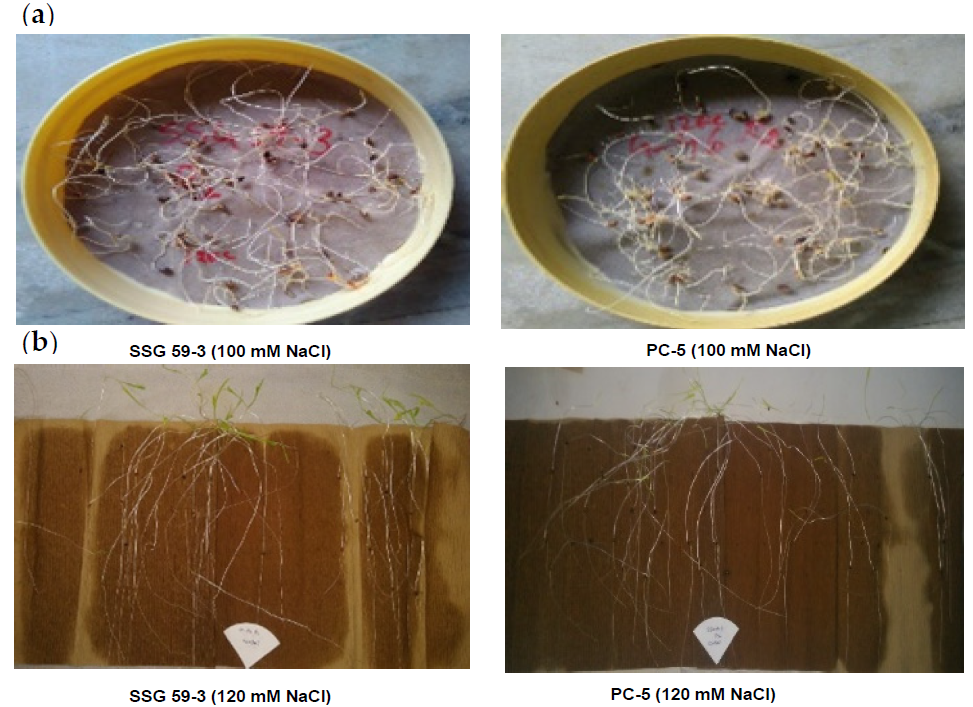
Figure 1. Germination experiment in sorghum genotypes under salt stress. ( a ): Petri plate experiment; ( b ): between-paper experiment.